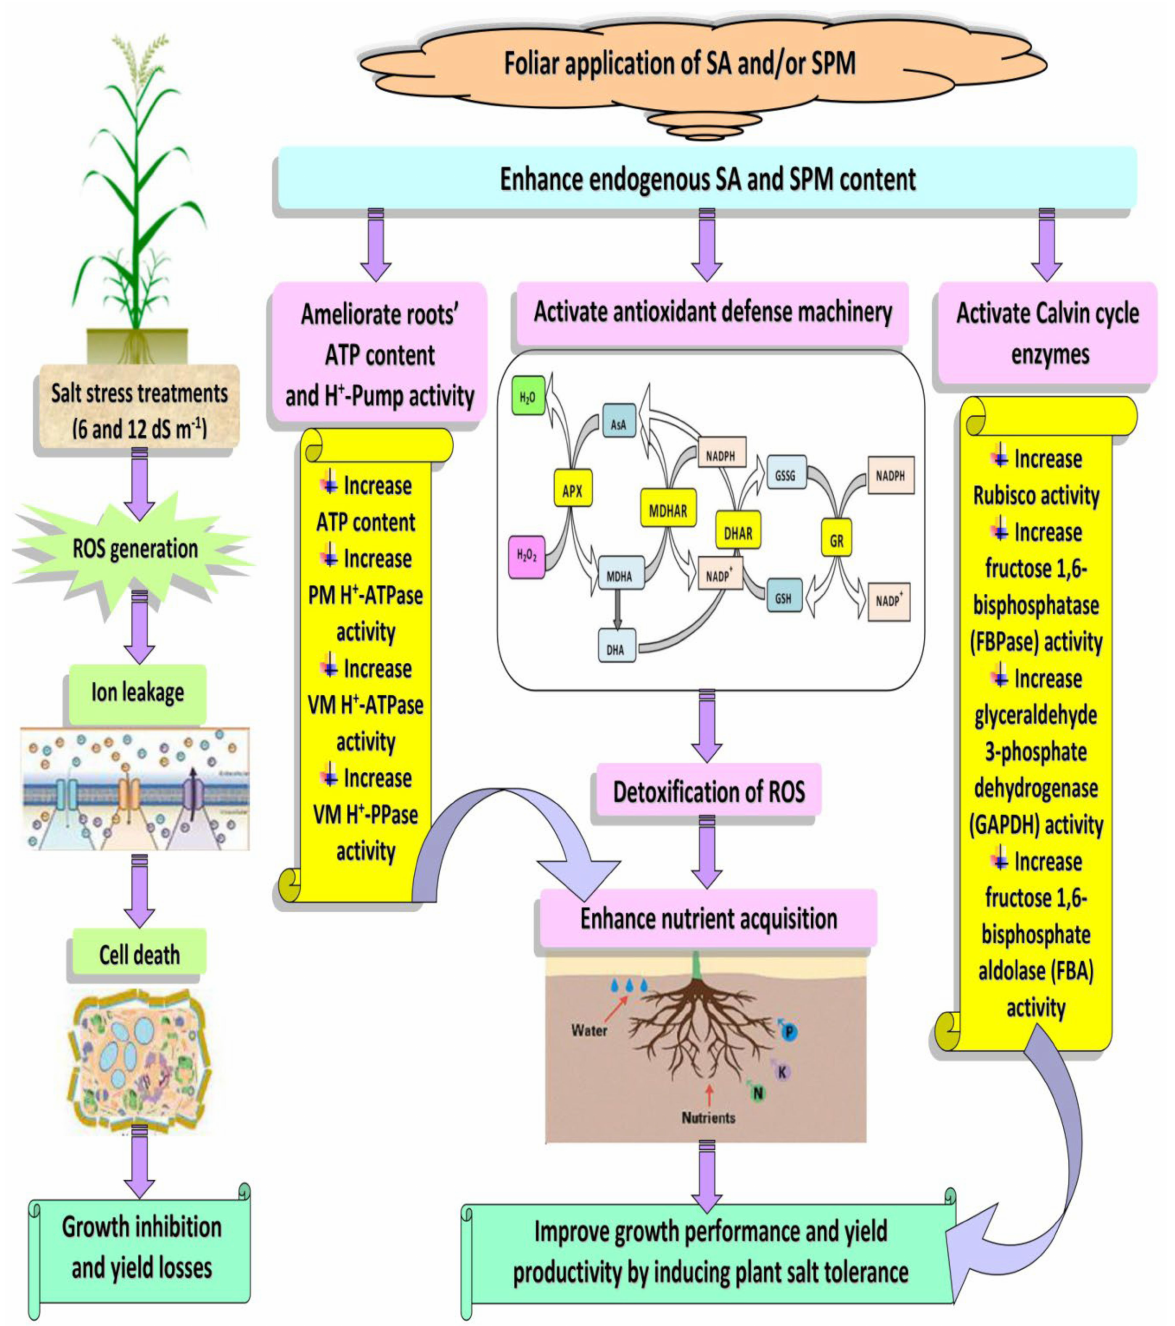
Figure 9. A model showing salt stress induces oxidative stress in wheat plants by increasing reactive oxygen species (ROS) generation. Meanwhile, salicylic acid (SA) and/or spermine (SPM) foliage applications reduce salt stress damage to the plants and improve growth performance and yield productivity by increasing endogenous SA and SPM concentrations that activate Calvin cycle enzymes and antioxidant defense machinery as well as ameliorate roots’ ATP content and H + -pump